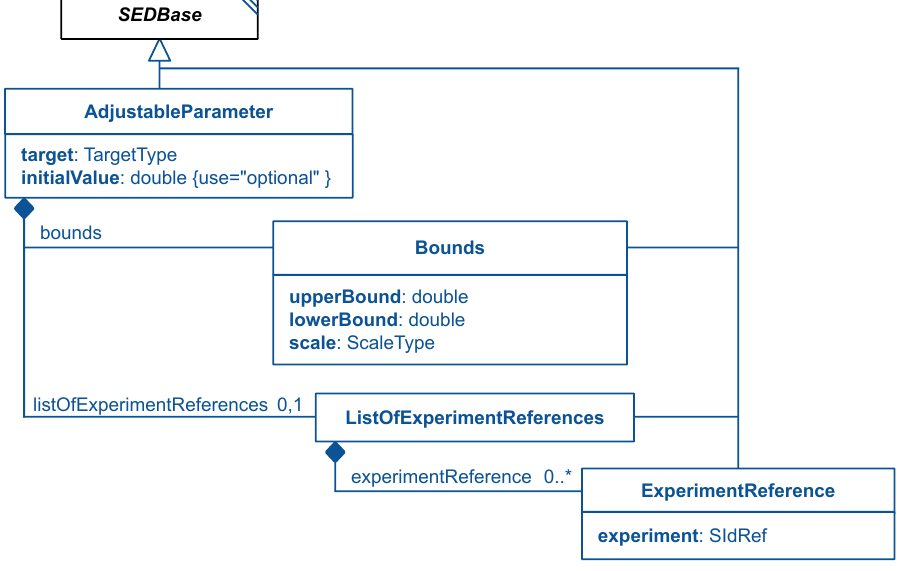
Figure 2.17: The SED-ML AdjustableParameter, Bounds, ListOfExperimentReferences, and Experi- mentReference classes